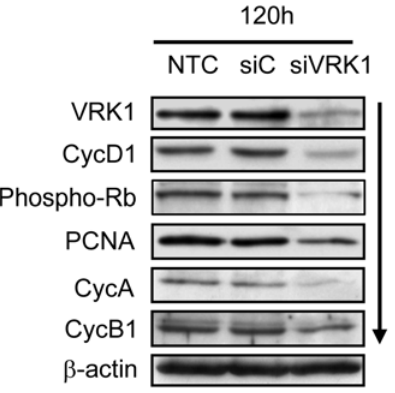
Figure 6. Effect of siVRK1 on proteins related with cell cycle progression. Levels of proteins in non-transfected, transfected with siRNA control, or with siRNA specific for VRK1 were determined in after 120 hours post transfection. The proteins were determined with the corresponding antibody indicated in the methods section, and identified in the corresponding immunoblot. These experiments were independently performed five times.